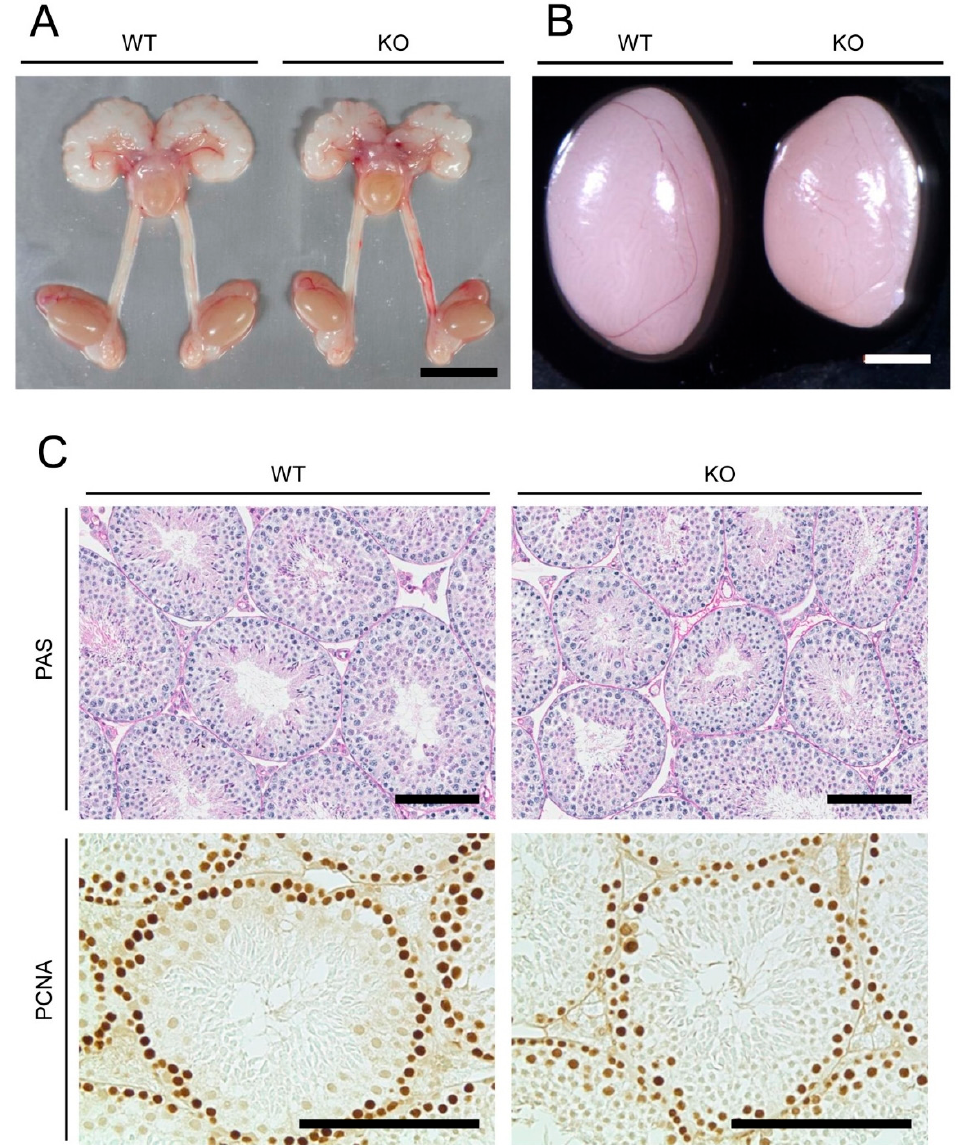
Figure 1. Morphological analyses. ( A ) Anatomy of male reproductive organs of wildtype (WT) and Mamld1 knockout (KO) mice at 20 weeks of age. Scale bars = 1 cm; ( B ) Testis morphology of WT and KO mice at 20 weeks of age. Scale bars = 2 mm; ( C ) Testis sections stained with periodic acid-Schiff (PAS) and proliferating cell nuclear antigen (PCNA) antibody in WT and KO mice at 8 weeks of age. Scale bars = 100 μ m.